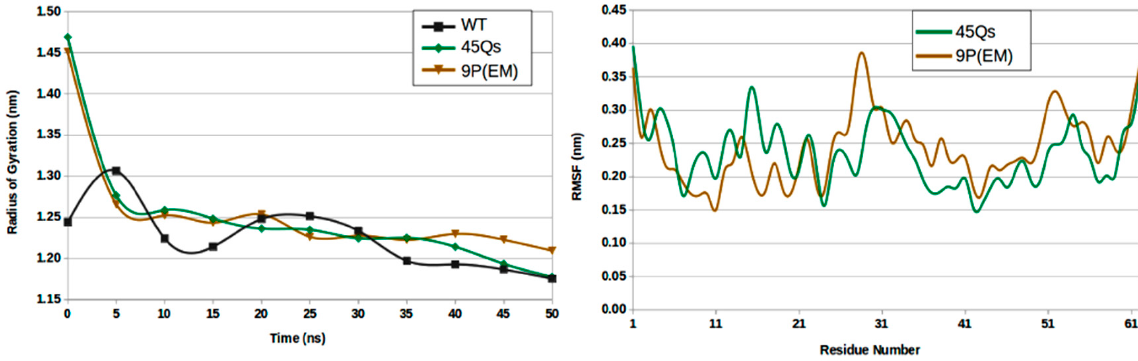
Figure 8. The radius of gyration ( left ) and RMSF ( right ) profiles for HTT models in their interaction with CaM.